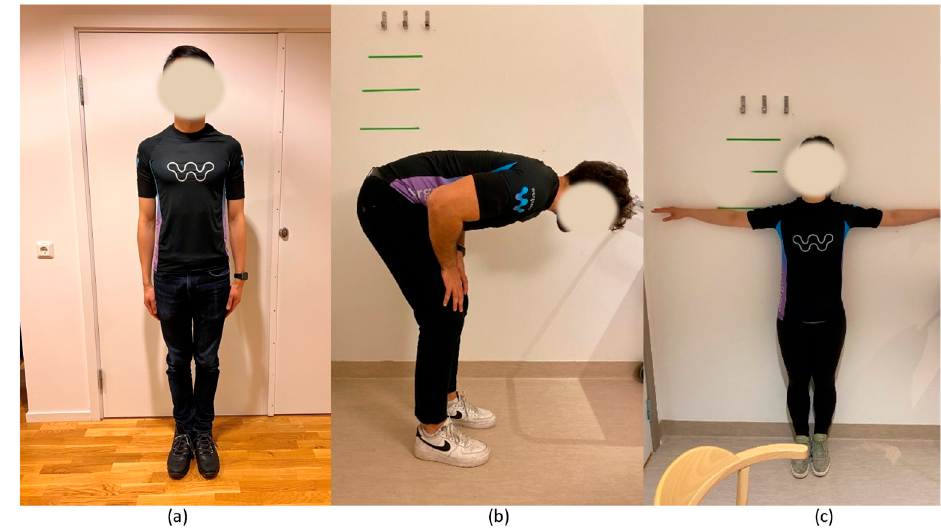
Figure 2. Calibration poses: ( a ) I-pose of standing straight with arms relaxed by the body; ( b ) forward trunk bending at about 90 degrees; and ( c ) T-pose of standing straight with both arms lifted at about 90 degrees.